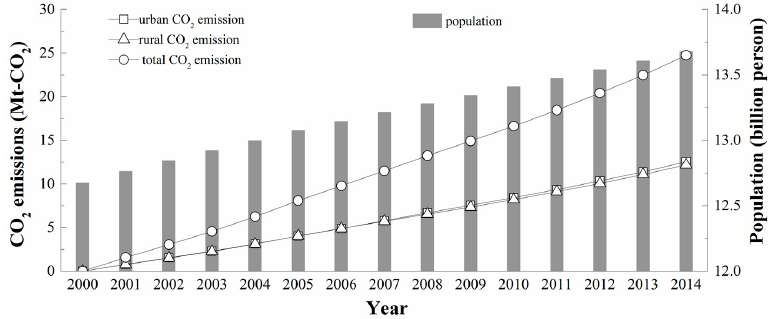
Figure 8. Accumulated changes in population scale effect on household CO 2 emissions and population in China (2000–2014).